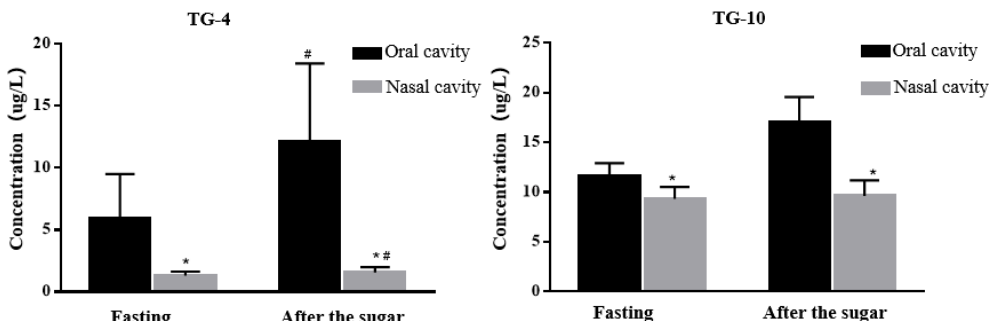
Figure 4. Difference between oral and nasal exhalation. Eight healthy volunteers drank the 5% glu- cose solution and immediately blew into two sampling bags in parallel with each other in the mouth and nose. Values and error bars represent mean ± SE. * nasal cavity compared with the oral cavity, p < 0.05, and # compared fasting after sugar.